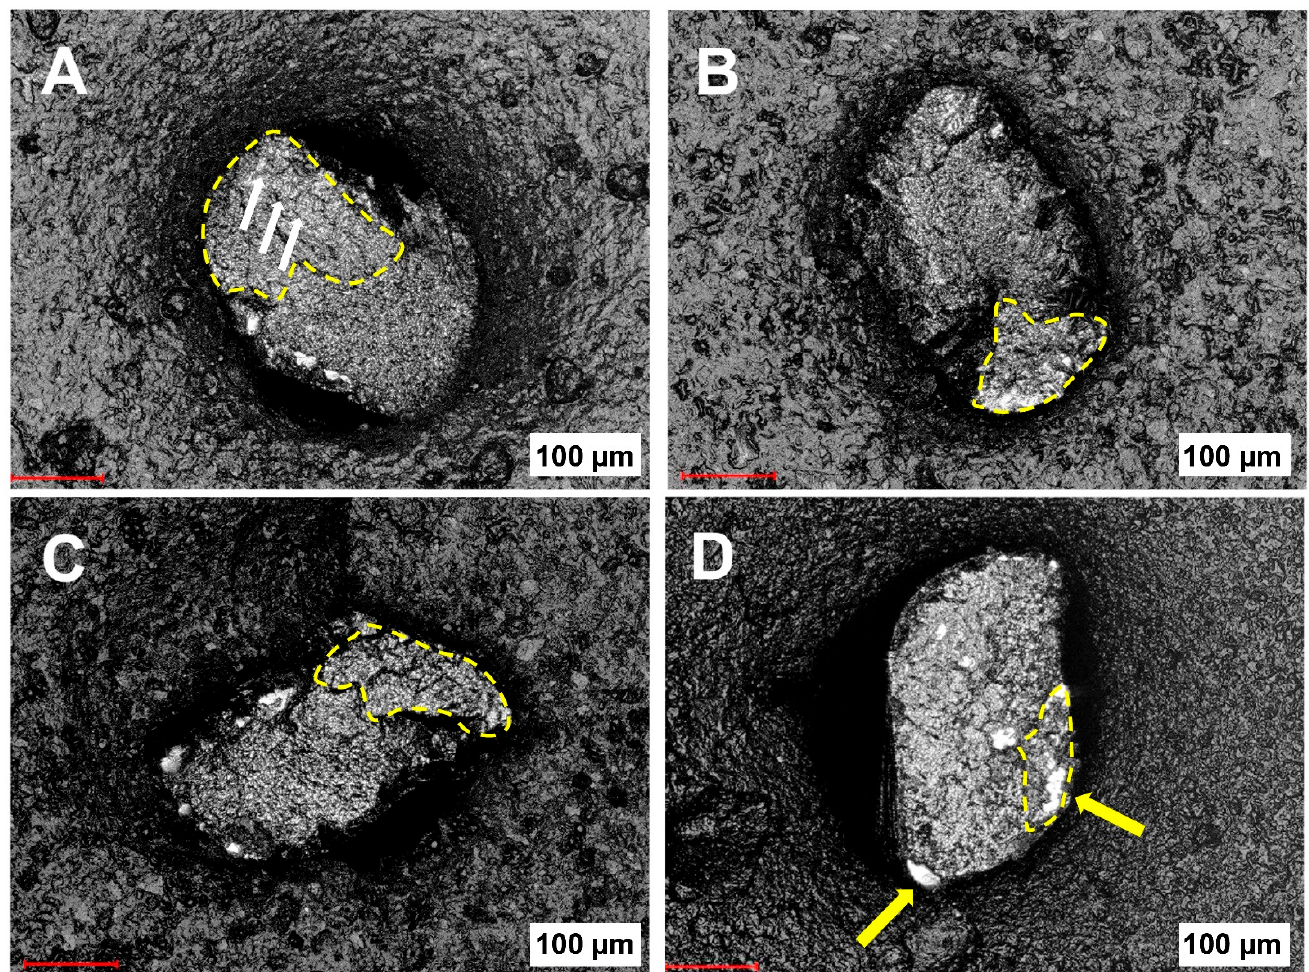
Figure 6. Exemplary surfaces of fractured instruments: ( A ) matching canal (+0.02 mm). The fractured cross-section the instrument shows an area of fatigue propagation = striation area (white arrows), delimited by the shiny dotted line, visible starting from the origin of the fracture at the top of the file. A huge rippled area nearly over the complete cross-section is visible. ( B ) +0.05 mm. ( C ) +0.10 mm. Typical for instruments with S-shaped cross-section, fractures usually start in the regions with the largest distance to the neutral fiber (propagation area = yellow dotted line). ( D ) Parallel tube (1.25 mm). The fractured cross-section shows two propagation areas (yellow dotted line and arrows)—one starting from the cutting edge at the bottom, and the other at the right side in the convex and straight portion.